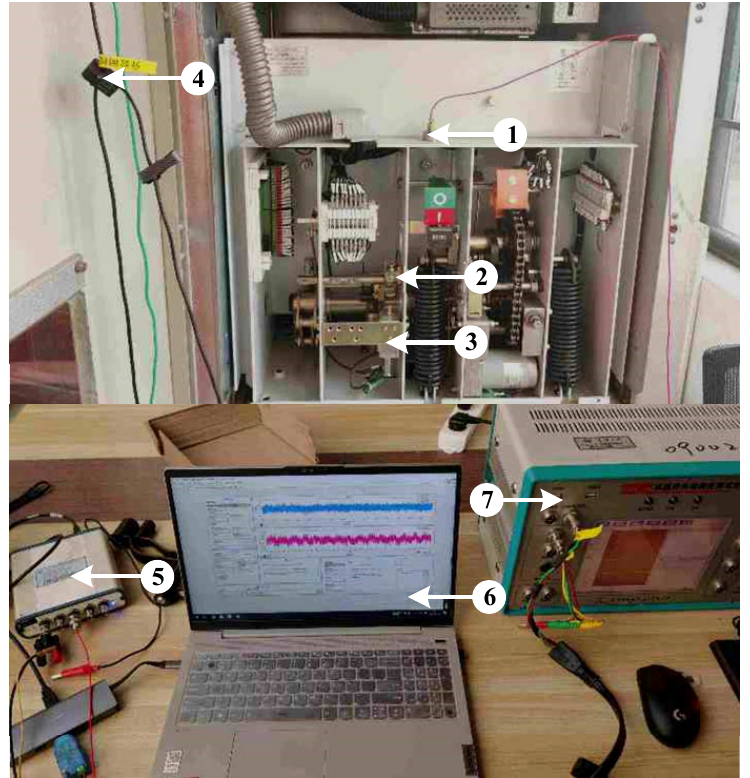
Figure 1. Measurement test of the CC and the vibration signals.